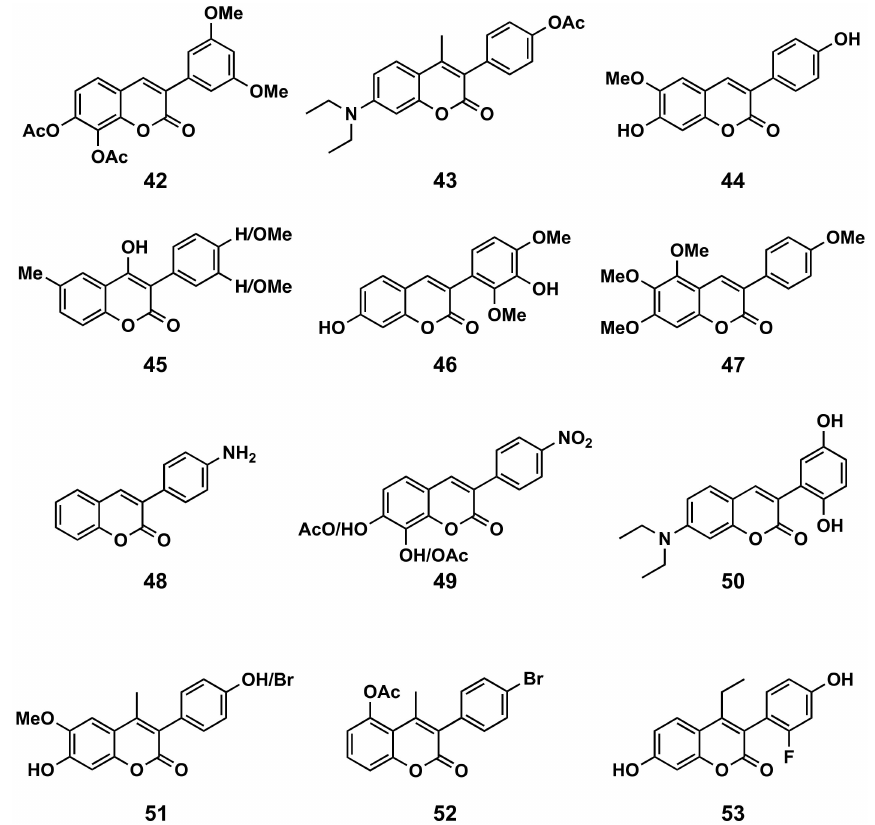
Figure 19. 3-Phenylcoumarins as anticancer agents: simple coumarins, without the incorporation of new cycles to the